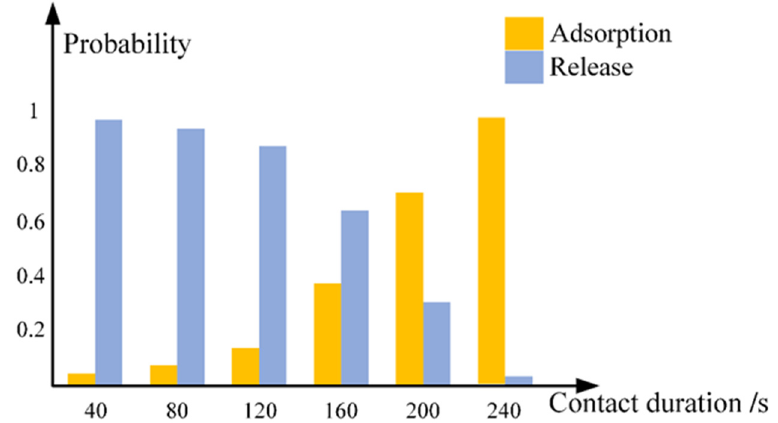
Figure 6. Release/adsorption probability vs. irradiation time between probe and nanorod. Contact strategy 3 was used. SEM acceleration voltage is 5 kV. Adsorption probability reached over 95% when contact time exceeds 4 minutes.